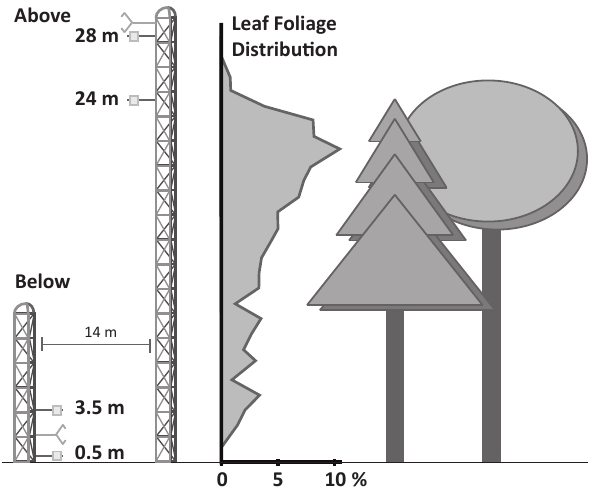
Figure 2. Meteorological equipment and gas inlets installed on the Environmental Measurement Site (EMS) tower and a small tower installed 14m to the north-northwest of the EMS tower over undis- turbed soil. Squares represent gas inlets and temperature shield lo- cations. Sonic anemometers, sketched in gray, were installed at 2 and 29m. The distribution of foliage per meter of height (leaf fo- liage distribution) at the Harvard Forest EMS site in summer has a median height of